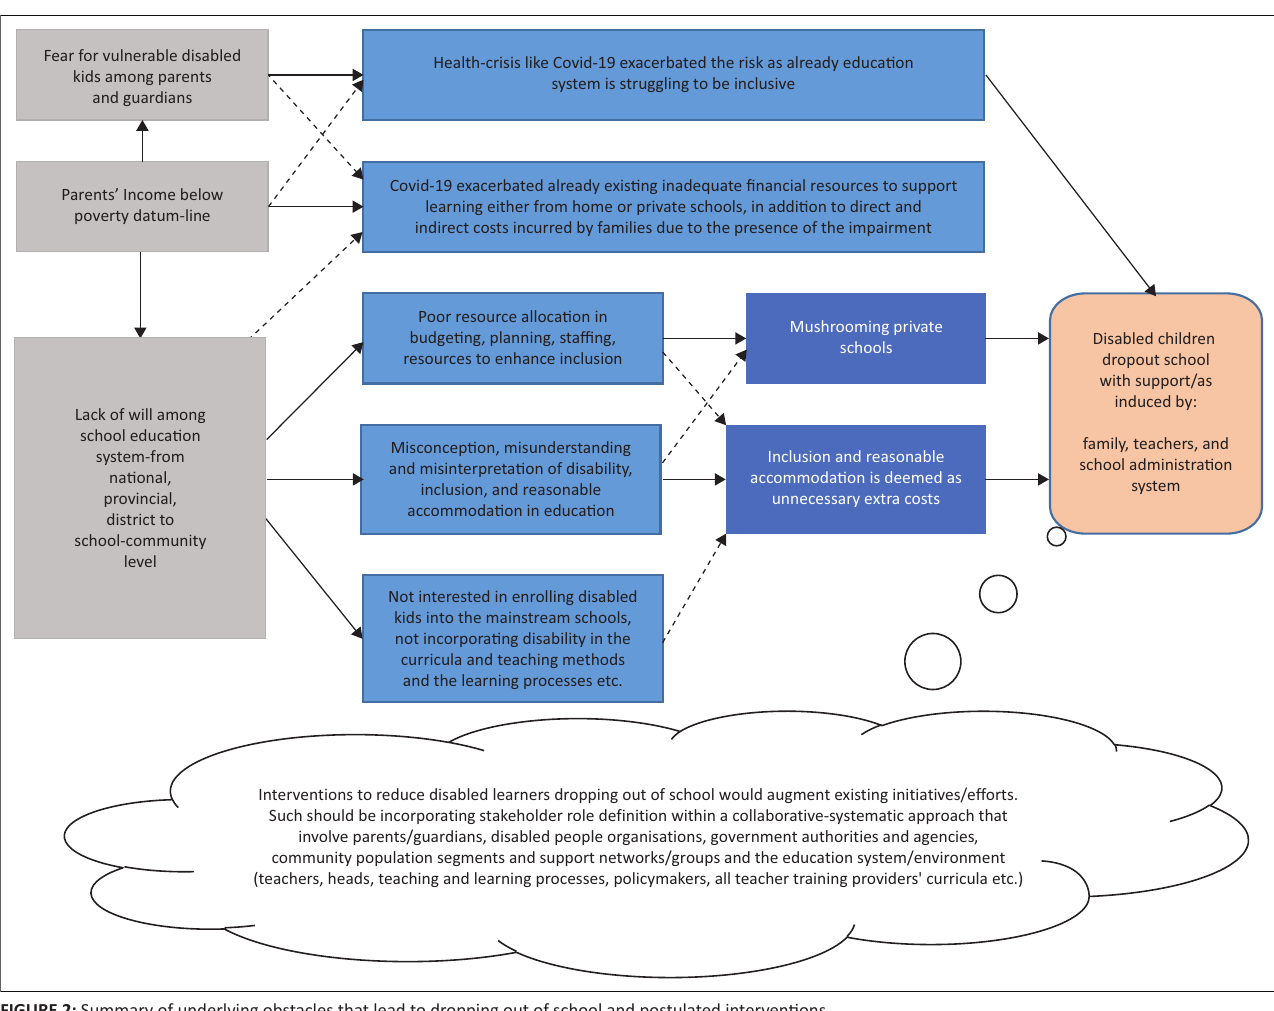
FIGURE 2: Summary of underlying obstacles that lead to dropping out of school and postulated